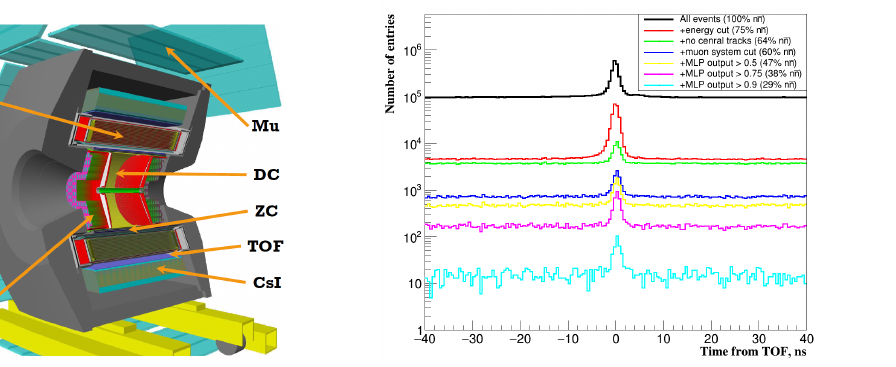
Figure 1: CMD-3 detector. Figure 2: The number of remaining events after di ff erent